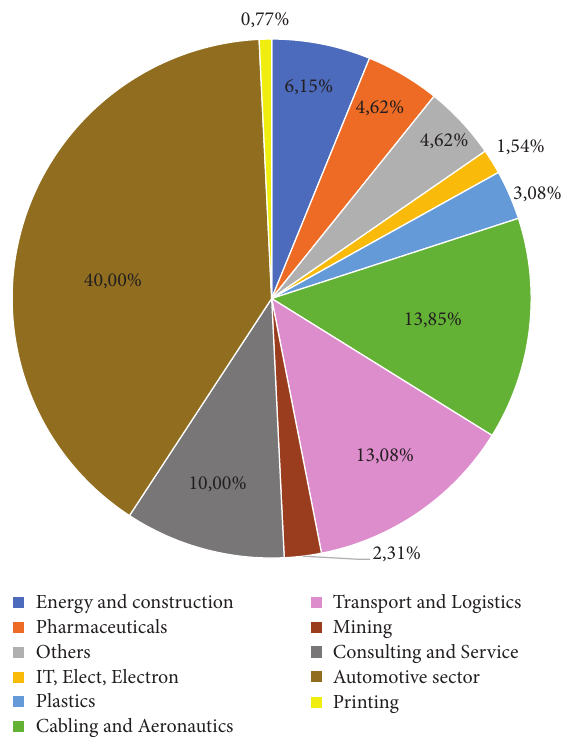
Figure 6: Types of business sectors.